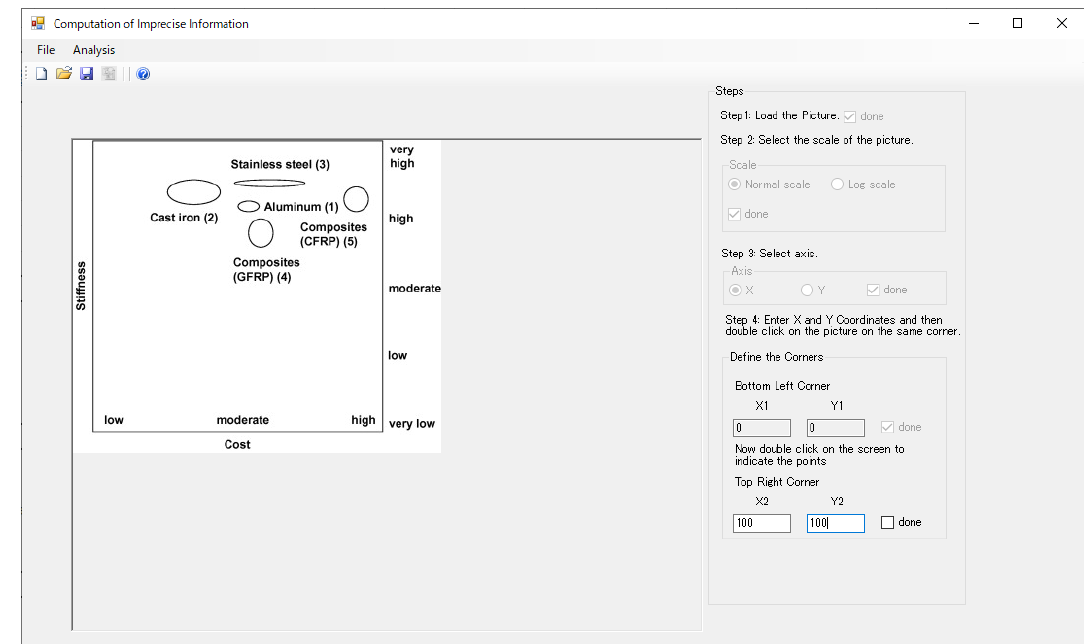
Figure 5. The user interface of the decision tool.